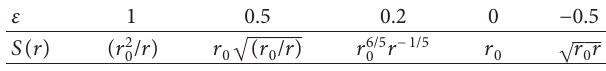
Table 1: Shape functions corresponding to different values of ε